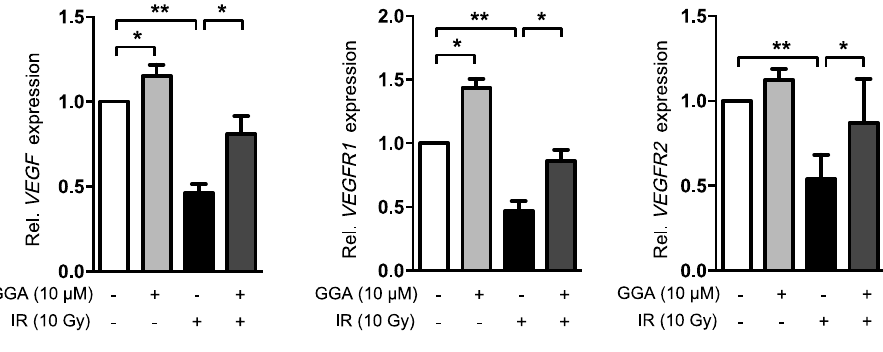
Figure 6. Effects of GGA on the wound-healing activity of endothelial cells. The distance between the wound margins in DMSO- or GGA-treated HUVEC monolayers with or without radiation was represented as a percent of the control value in would healing assays. The confluent cell layers were scratched and incubated for 12 h with 10 µM GGA with or without 10 Gy of IR treatment. The distance of the wound covered by the migrated cells after 12 h was measured and compared to the distance when the wound was scratched at 0 h; between the two lines on the photo (40×). Each assay was independently repeated three times; ** p < 0.01.